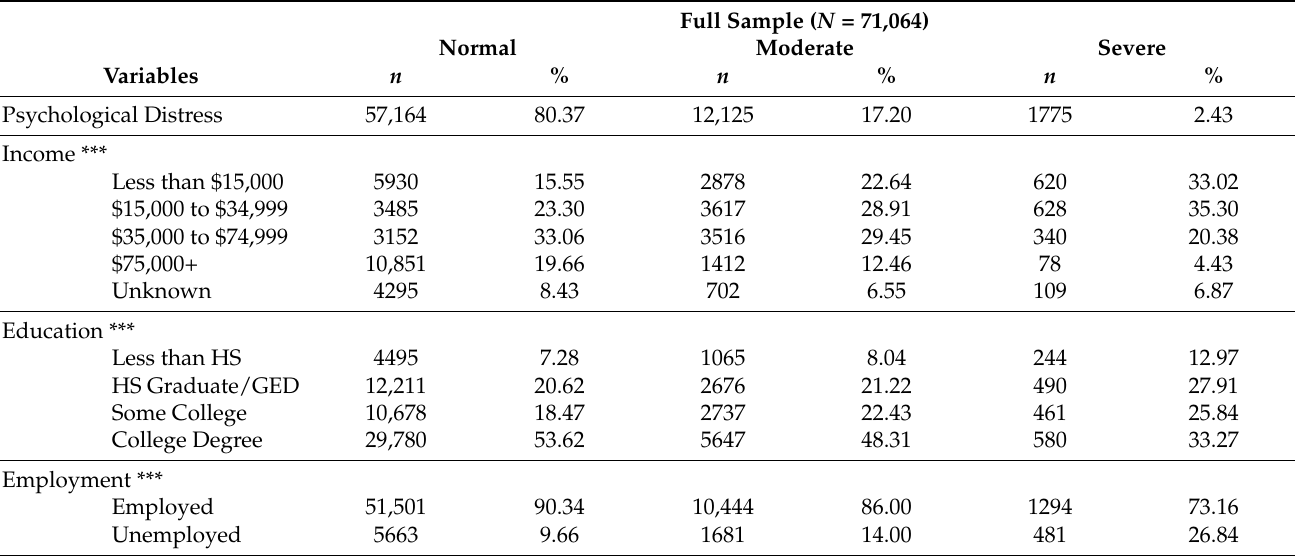
Table 2. Psychological Distress by Income, Education and Employment for Weighted Full